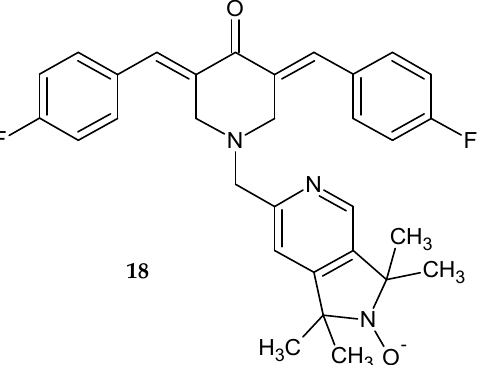
Figure 13. N ‐ oxide 3,5 ‐ bis(4 ‐ fluorobenzylidene) ‐ 1 ‐ (1,1,3,3 ‐ tetramethyl ‐ 1,2 ‐ dihydropyrrolo[3,4 ‐ c ]pyridin ‐ 6 ‐ yl)piperidin ‐ 4 ‐ on 18 .